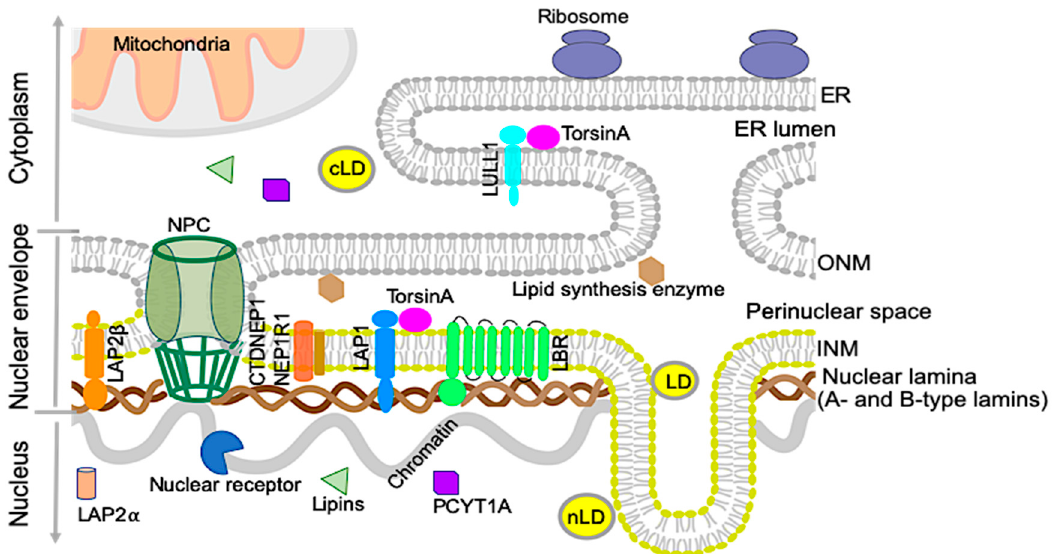
Figure 1. The organization of the nuclear envelope and endoplasmic reticulum (ER). Schematic diagram of the nuclear envelope and ER showing the nuclear membranes, nuclear lamina, and nuclear pore complex (NPC). The nuclear lamina contains A- and B-type lamins. The outer nuclear membrane (ONM) is contiguous with the ER, containing lipid synthesis enzymes and ribosomes. The ER lumen is directly continuous with the perinuclear space. Selected proteins, such as lipid synthesis enzymes concentrated in the ER and inner nuclear membrane (INM), are shown along with torsinA in the perinuclear space. Lamina-associated polypeptide 1 (LAP1) is shown interacting with lamins and torsinA. Two isoforms of LAP2 are shown in the nucleoplasm (LAP2 α ) and INM (LAP2 β ). Some of the nuclear receptors that regulate gene expression are known to interact with nuclear lamins or lamin-associated proteins. Some enzymes involved in phospholipid biogenesis (CTDNEP1/NEP1R1, lipins, and PCYT1A) are localized in the nucleus or NE. TorsinA interacts with LAP1 at the nuclear envelope (NE) and luminal domain-like LAP1 (LULL1) in the main ER. Lipid droplets are mainly synthesized in the ER and present in the cytosol as cytosolic lipid droplets (cLDs). Certain types of cells contain nuclear lipid droplets (nLDs) within the nucleus. Mitochondria and ribosomes are localized in the cytoplasm.